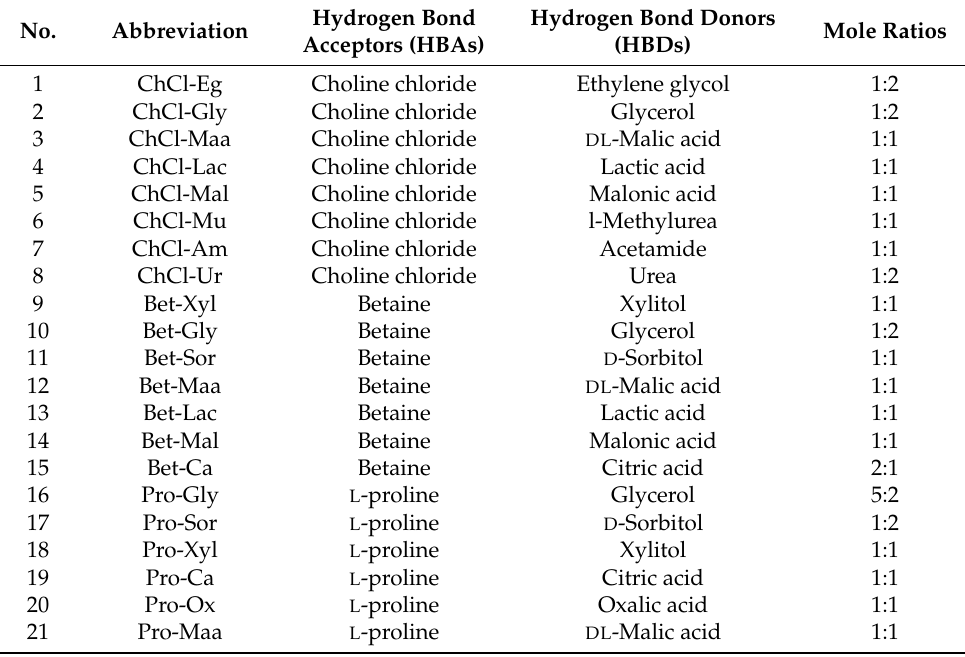
Table 2. List of natural deep eutectic solvents (NADESs) synthesized in this